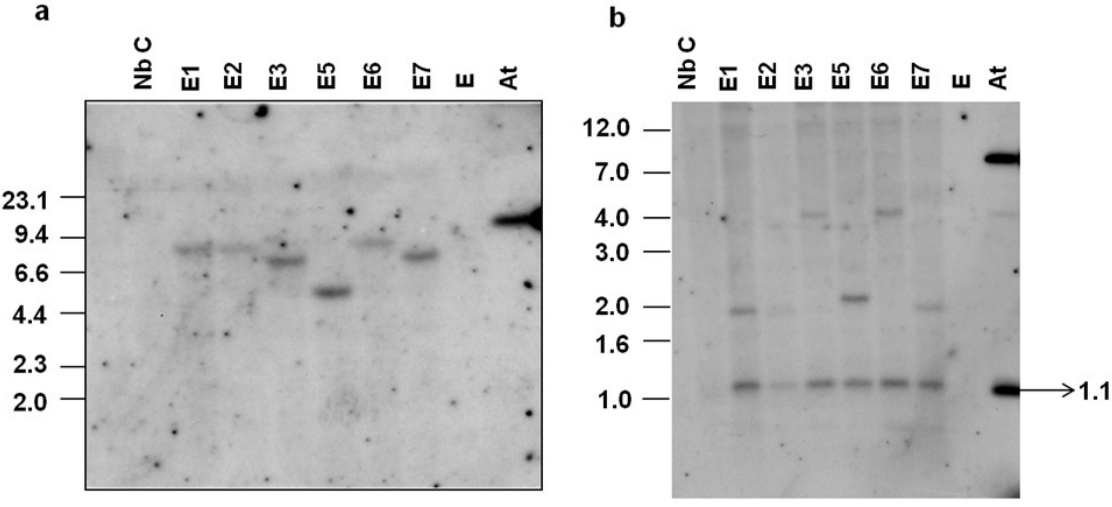
Figure 2. ( a ) Southern blot analysis of virE2 transgenic Nicotiana benthamiana plants with the hpt probe. Total DNA (10 µg) from transgenic (E1-E7) as well as control (Nb C)